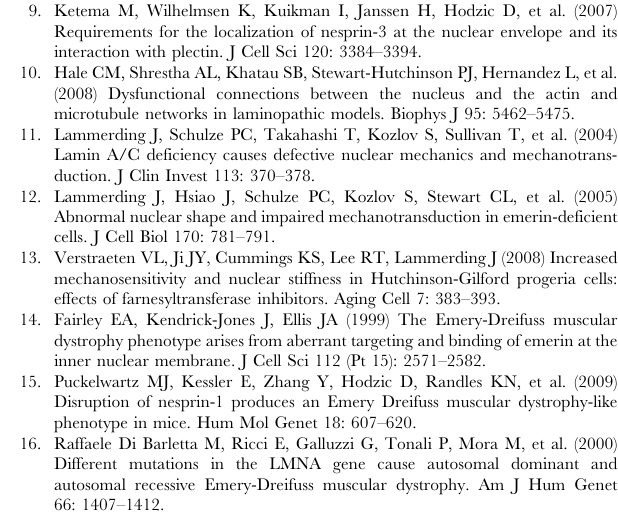
Figure S1 Localizations of p23 Nesp1 , p12 Nesp1 and p41 Nesp1 . A) p23 Nesp1 , p12 Nesp1 and p41 Nesp1 displayed diffusive cytoplasmic localization when transfected into U2OS cells. B) the ER when transfected into HDFs. Figure S2 Schematics of nesprin-1 and nesprin-2 cas- sette exons. A) Nesprin-1 genomic map showing the location of nesprin-1 cassette exon 6 9 (Red box). B) Nesprin-2 genomic map showing the location of nesprin-2 cassette exons 101’ (orange box) and107’ (Purple box).